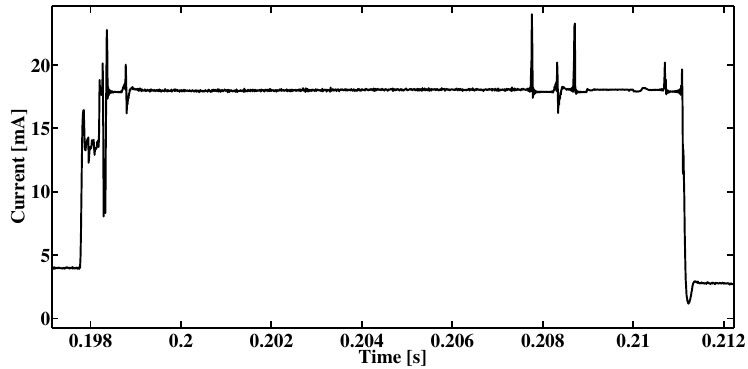
Figure 4. OS tier simulation: Sending 2 bytes of data with AMSend.